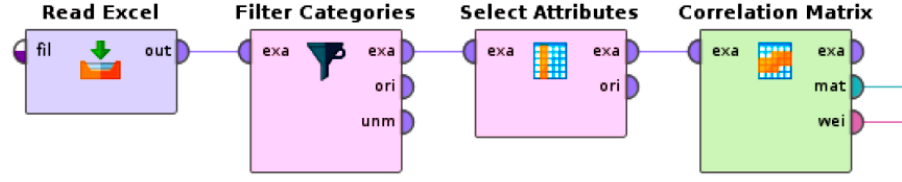
Figure 6. A workflow for a correlation matrix to visualize the attributes magnitude for Task 5, where the input dataset is the result of the monitoring stations clustering.